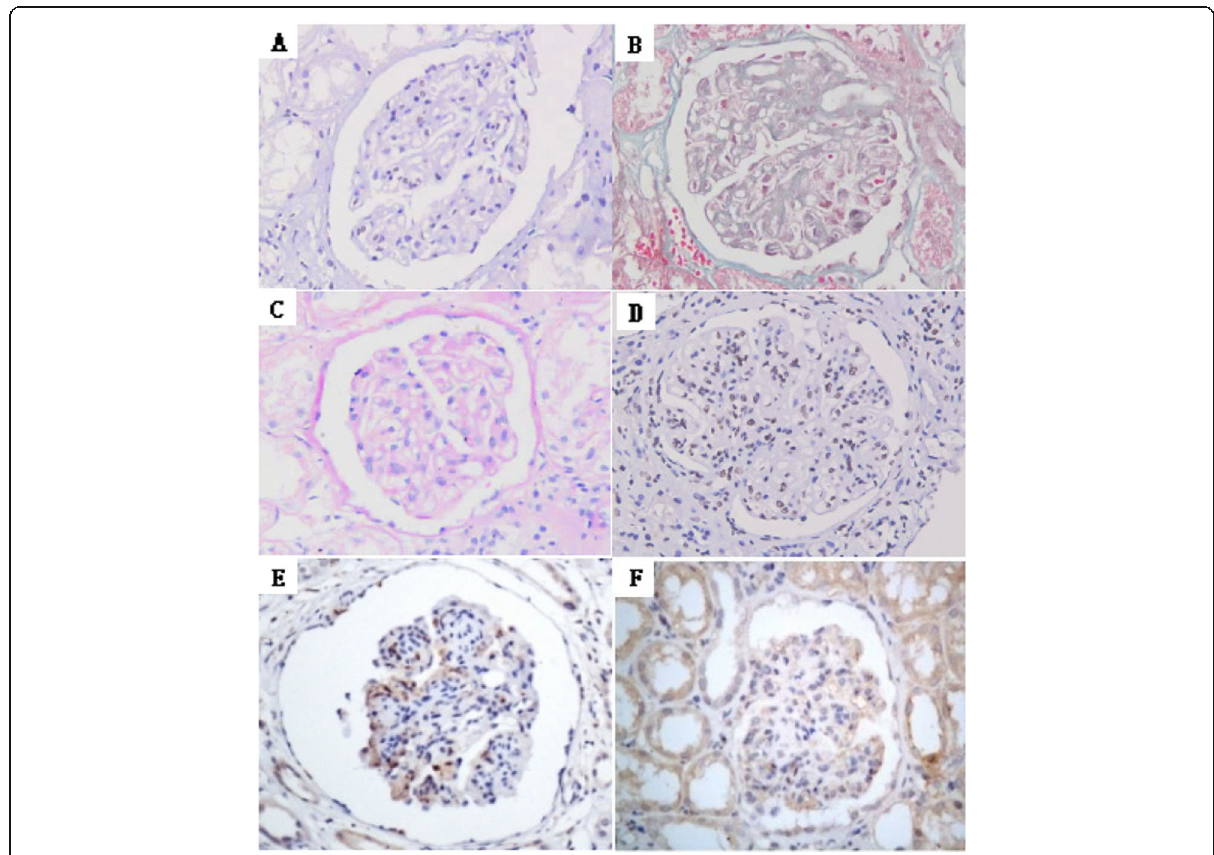
Fig. 2 A Light microscopic manifestation of HBV-GN, HE,400×. B Light microscopic manifestation of HBV-GN, Masson,400×. C Light microscopic manifestation of HBV-GN,PAS, 400×. D IFI16 positive staining in nucleus of endothelial cells, mesangial cells and podocytes in HBV-GN, IHC 400×. E Caspase-1 positive staining in cytoplasmic and nucleus of glomerular endothelial cells and mesangial cells in HBV-GN,IHC 400×. F IL-1ß positive staining in cytoplasmic and nucleus of glomerular endothelial cells and mesangial cells in HBV-GN,IHC 400×